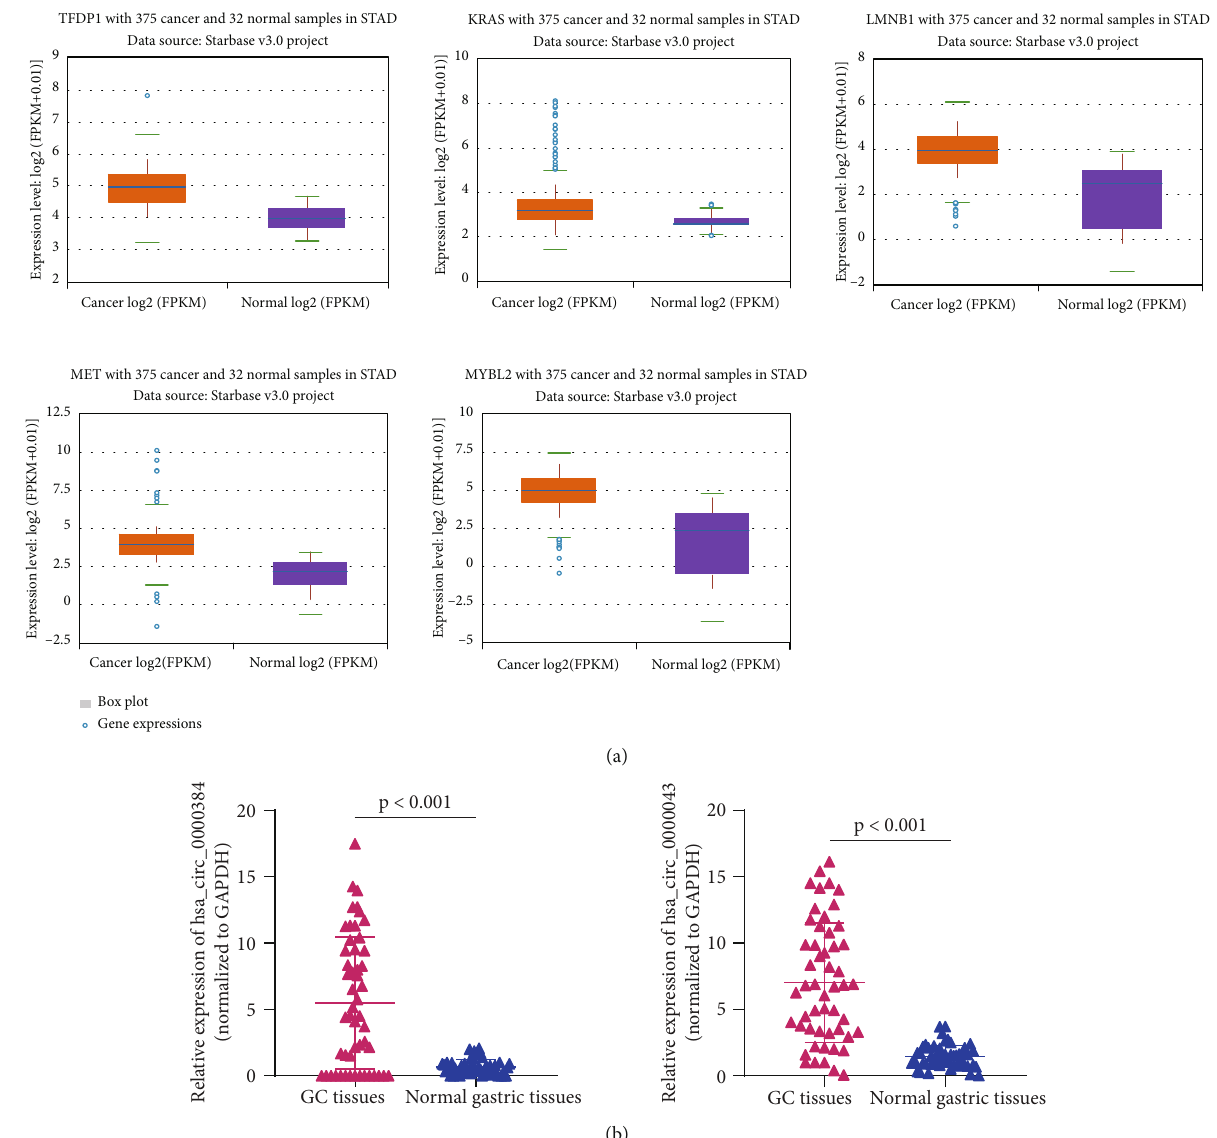
Figure 6: (a) Expression patterns of TFDP1, KRAS, LMNB1, MET, and MYBL2 in GC using the starBase database. (b) Relative expression levels of hsa_circ_0000384 and hsa_circ_0000043 in cancerous and matched noncancerous gastric tissues surgically resected from 52 GC patients were determined by RT-qPCR, normalized to